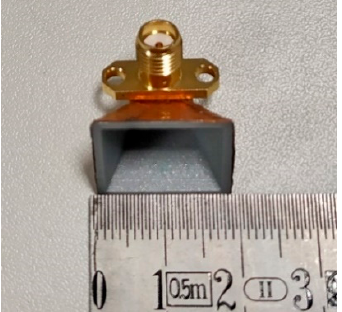
Figure 2. 3D-printed horn antenna with copper tape.